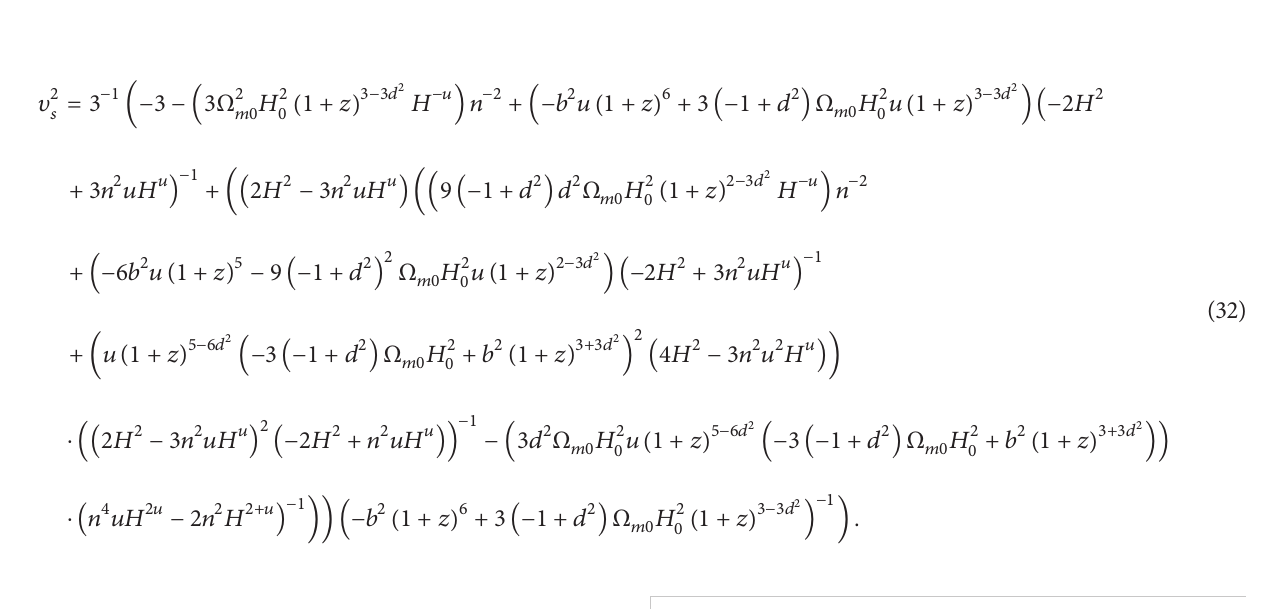
Figure 3: Plots of 𝐻 versus 1 + 𝑧 for event horizon PDE model in dynamical Chern-Simons